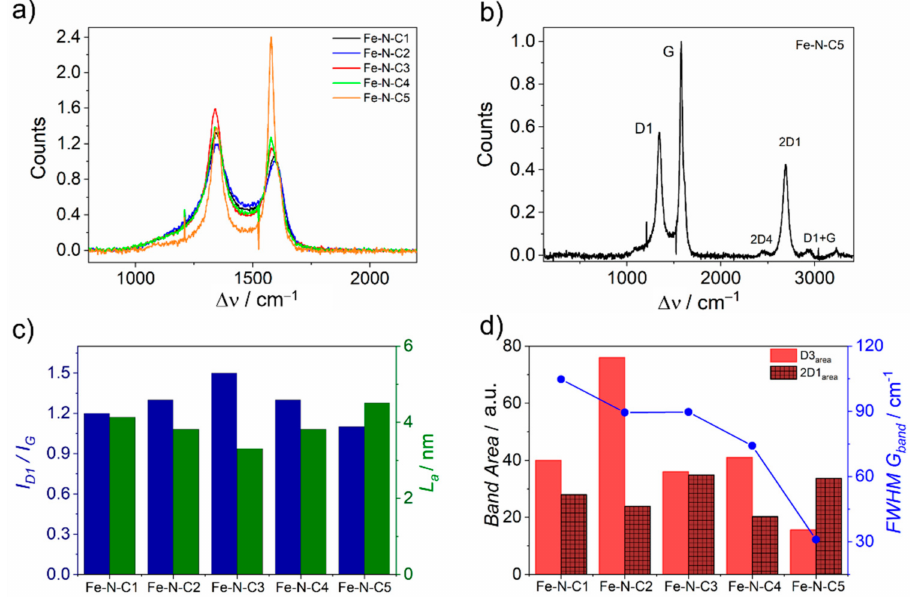
Figure 3. ( a ) Overlay of spectra acquired in different synthetic condition; ( b ) Full range Raman spectrum for Fe-N-C5; ( c ) I D1 / I G ratio and L a variation within the set of Fe-N-C catalysts; ( d ) D3 and 2D1 band area and G band FWHM within the set of Fe-N-C